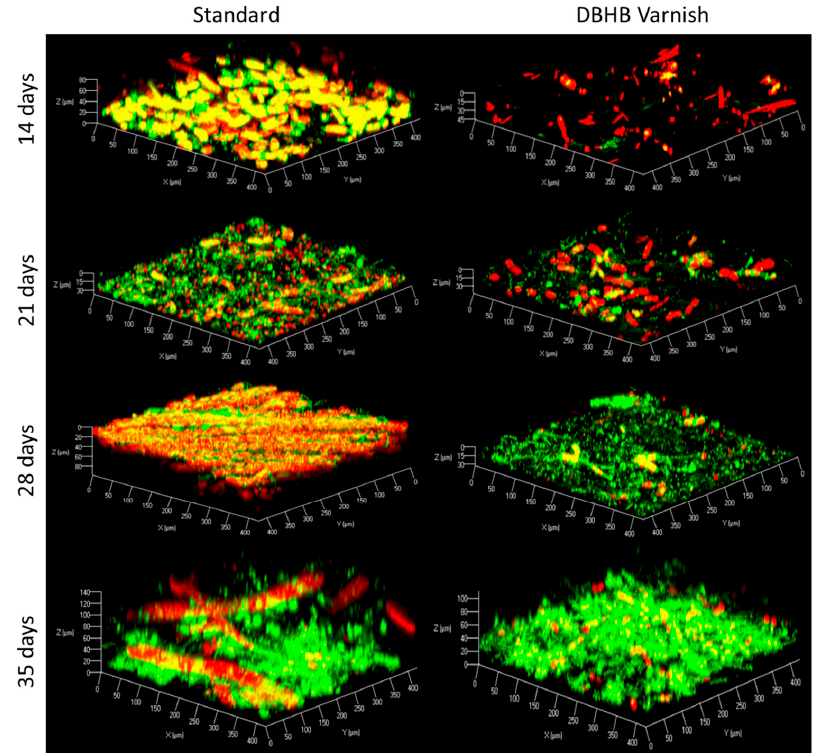
Figure 10. CLSM photography of microfouling developed on varnishes containing DBHB (DBHB varnish) and without DBHB (standard) during in vitro immersion (Kernevel Harbour). Color allocation: red, autofluorescence of chlorophyll; green (Syto 9), bacteria; yellow: overlay of microalgae and bacteria. Int. J. Mol. Sci. 2017 , 18 , 1520